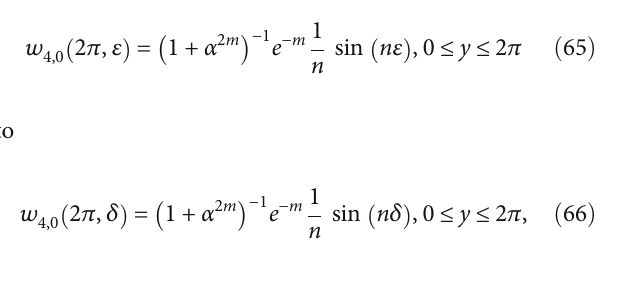
ffiffiffiffiffiffiffiffiffiffiffiffiffiffiffiffiffiffiffiffiffiffiffiffiffiffiffiffiffiffiffi n 2 − 1+ α 2 m ð ffiffiffiffiffiffiffiffiffiffiffiffiffiffiffiffiffiffiffiffiffiffiffiffiffiffiffiffiffiffiffi n 2 − 1+ α 2 m e 2 π